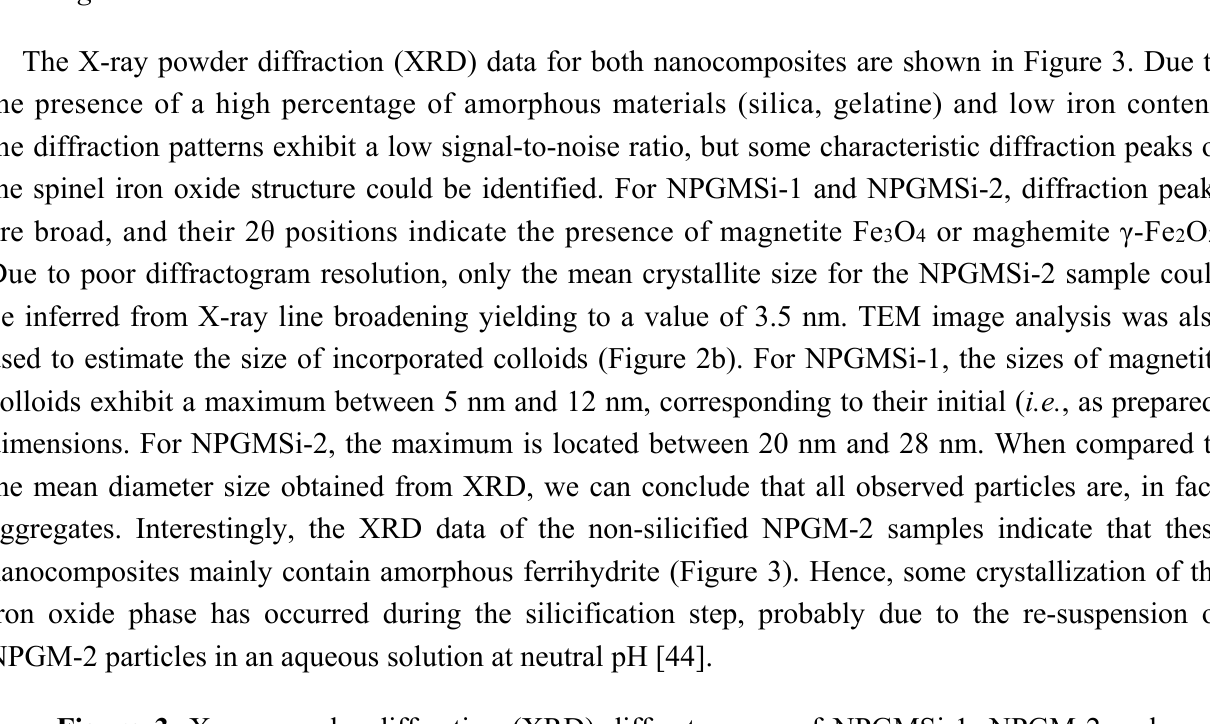
Figure 3. X-ray powder diffraction (XRD) diffractograms of NPGMSi-1, NPGM-2 and NPGMSi-2